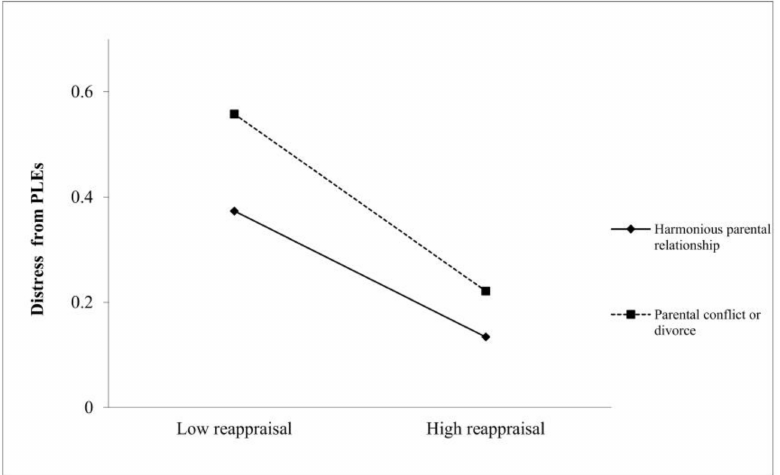
Figure 1. Plot of simple slopes for the interaction between parents’ relationship and the use of reappraisal on distress from